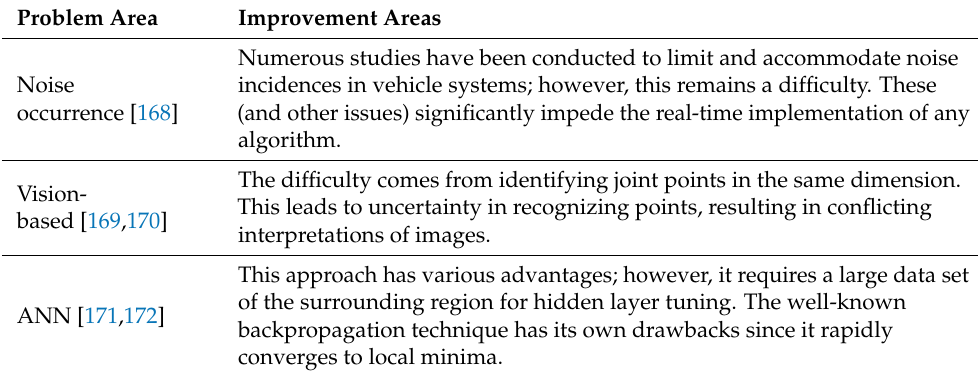
Table 4. Path planning